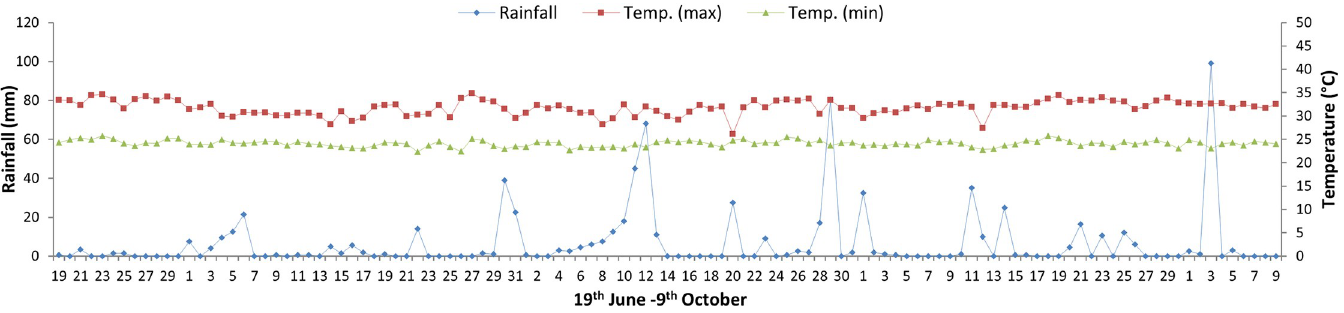
Fig 1. Daily rainfall, maximum and minimum temperatures in Yezin Agricultural University, Myanmar during wet season, 2016.